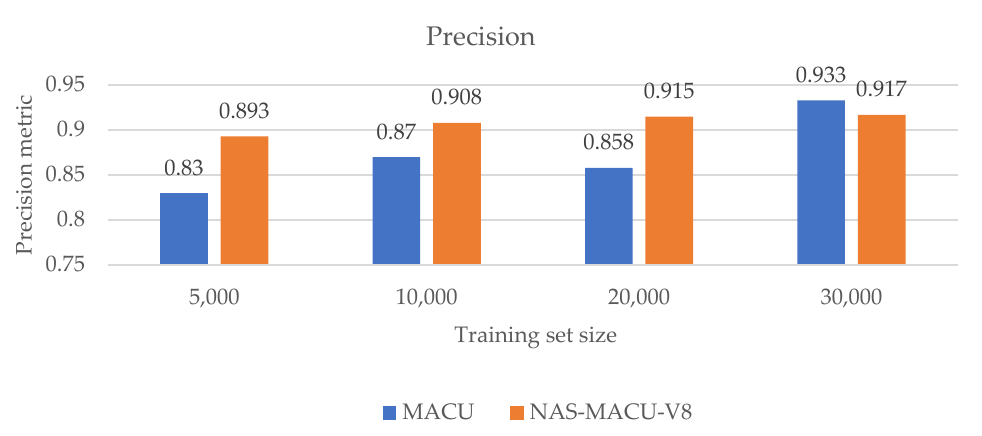
Figure 11. Precision performance of NAS-MACU-V8 vs. MACU in four different training set sizes.